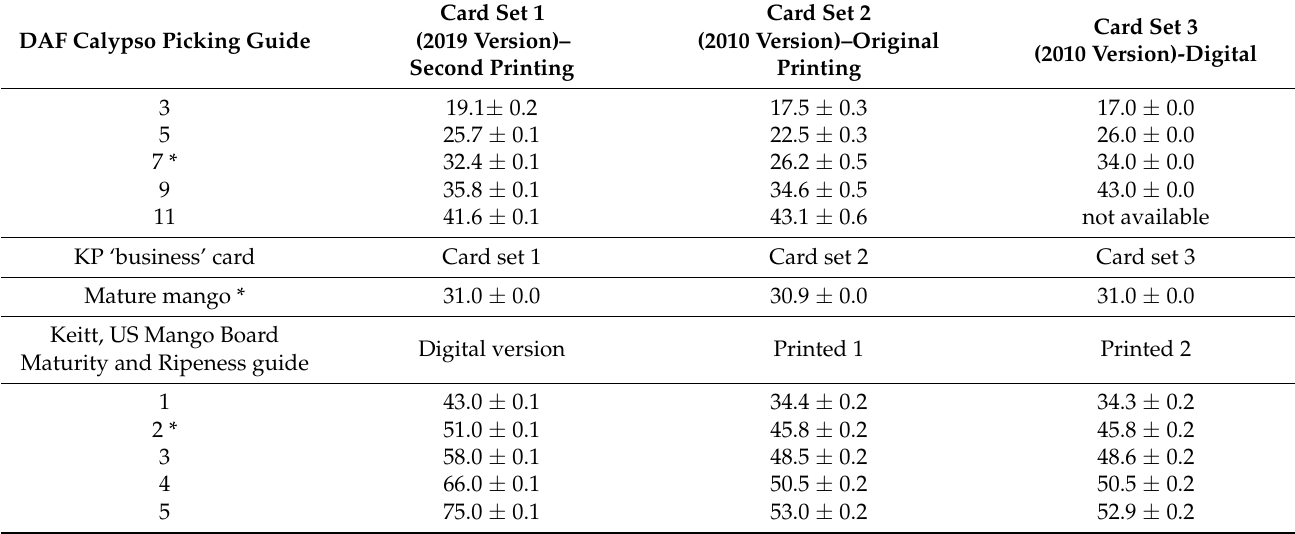
Table A2. CIE B value of mango harvest maturity colour cards. Data is presented for a Calypso card set of the original (2010) and of a second printing (2019), and values from the pdf of the file sent to the printer for the original printing. However, the cards of the second printing had been heavily used in field and were ‘aged’. Data for Keitt is from the pdf file of card swatches and from print. Data is presented of three original Kensington Pride ‘business cards’. Mean and SE of three replicate readings is presented.